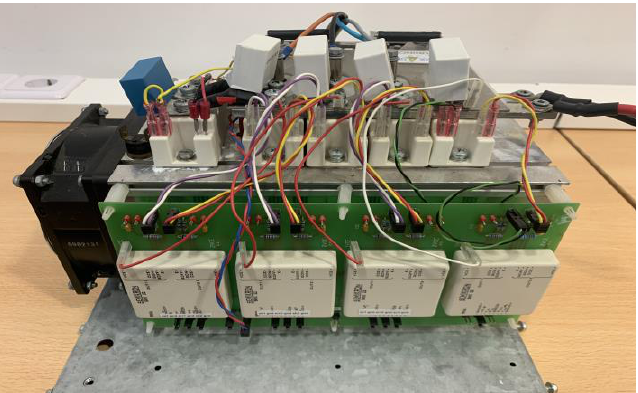
Figure 11. Three-phase PV inverter with four legs developed in the ambit of a European